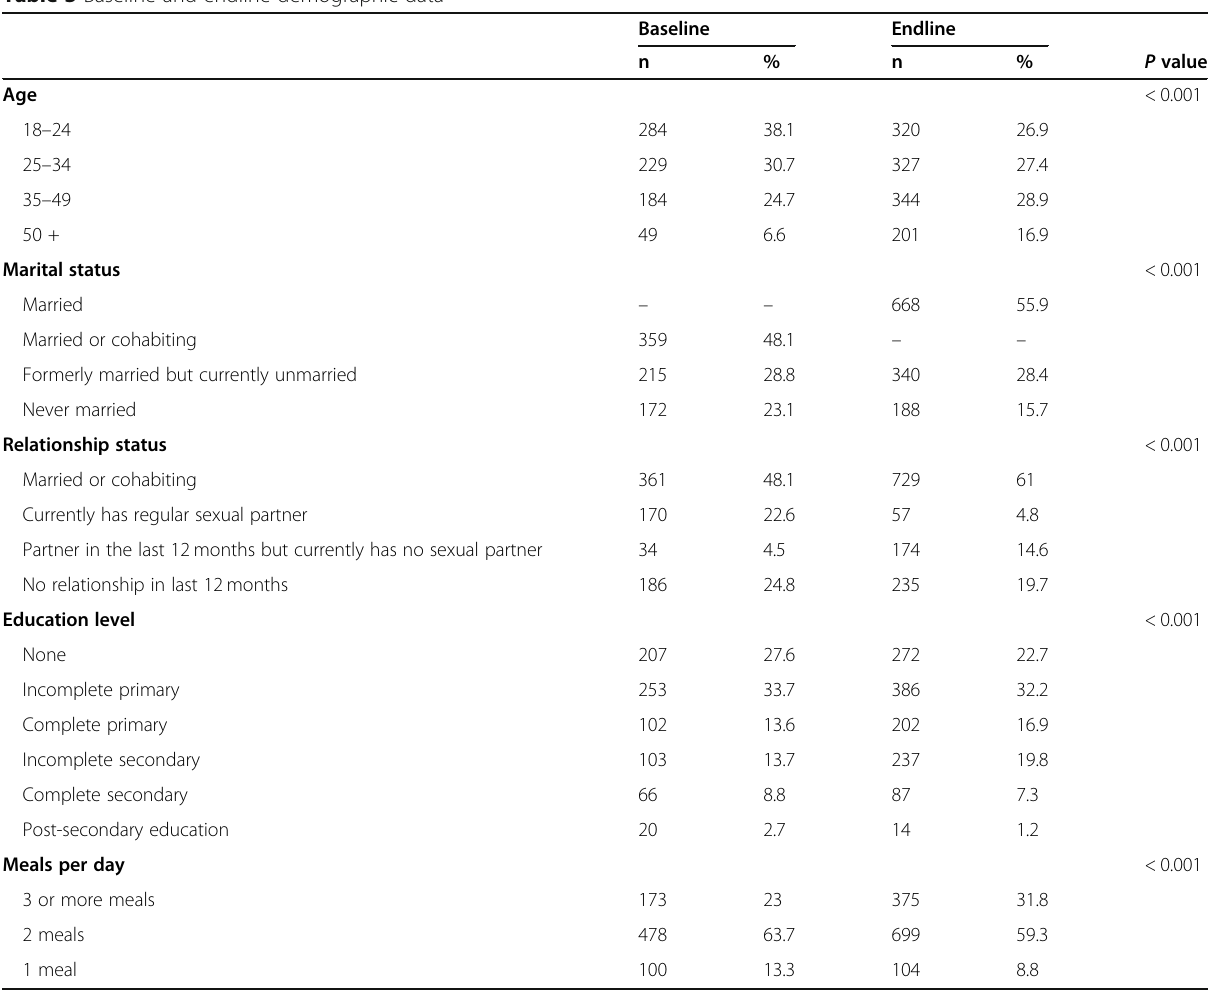
Table 3 Baseline and endline demographic